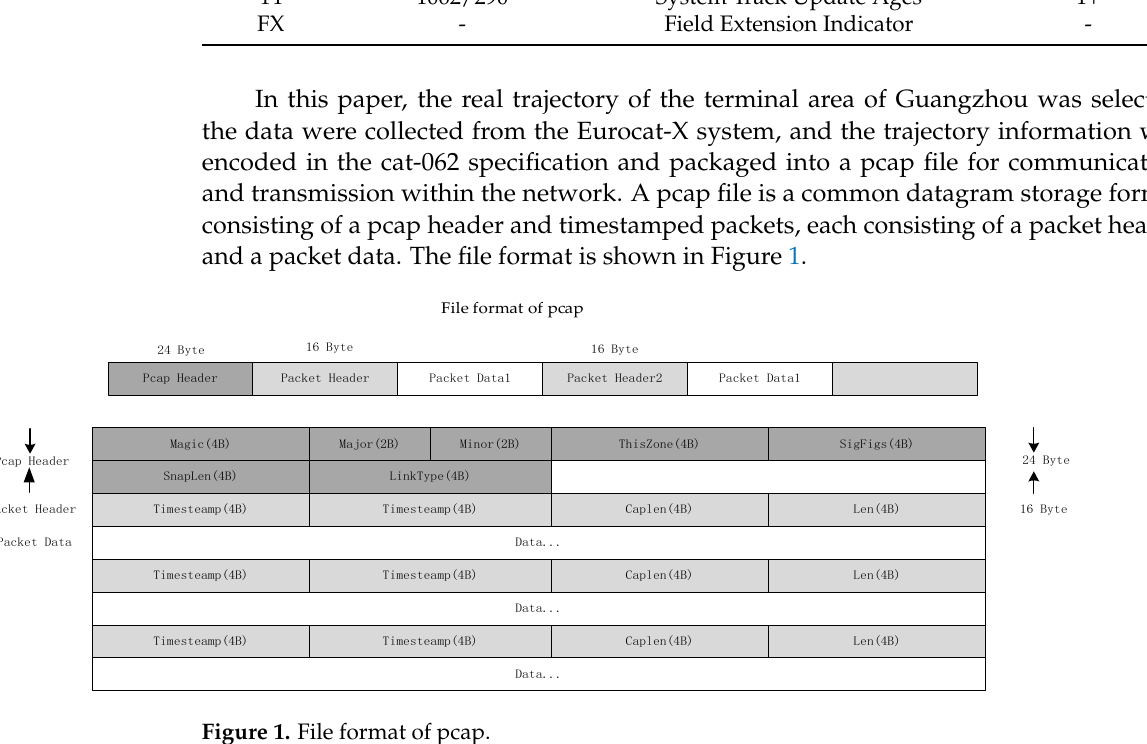
Table 2. Trajectory data.